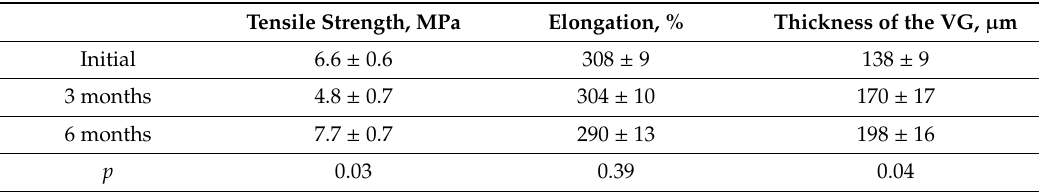
Table 3. Dependence of the strength of the vascular grafts made of Tec-80A on the time of their functioning in the rat infrarenal position.